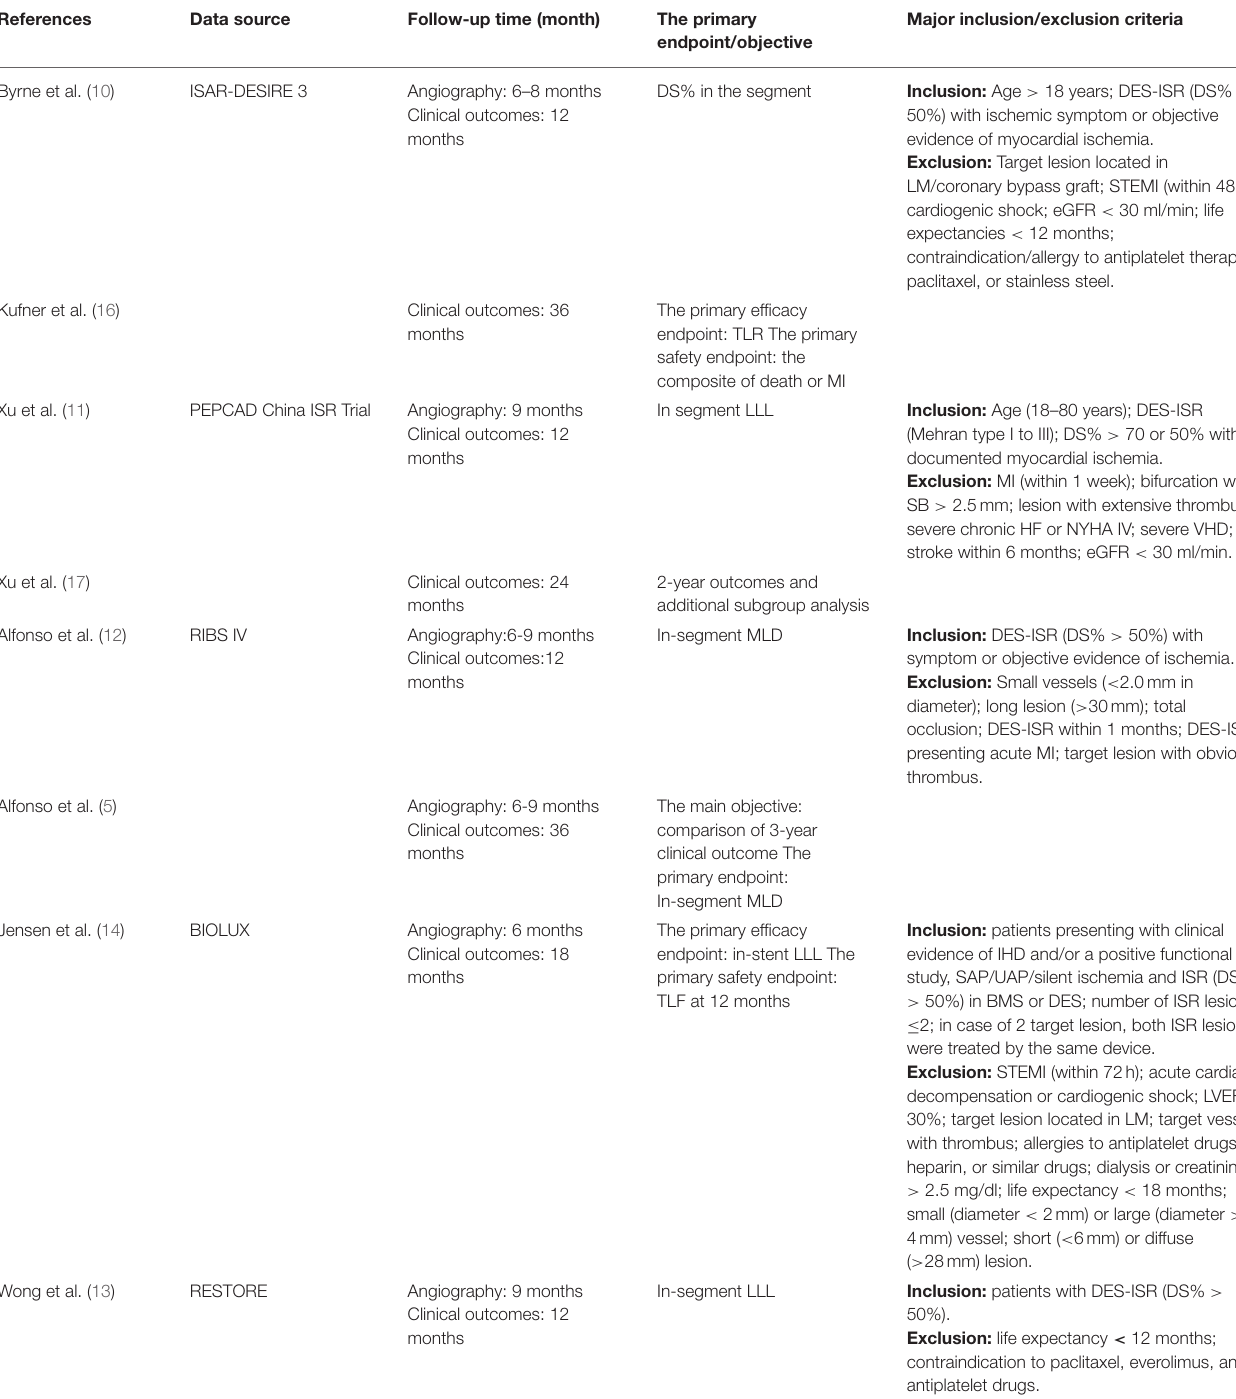
TABLE 2 | Reported outcomes and follow-up